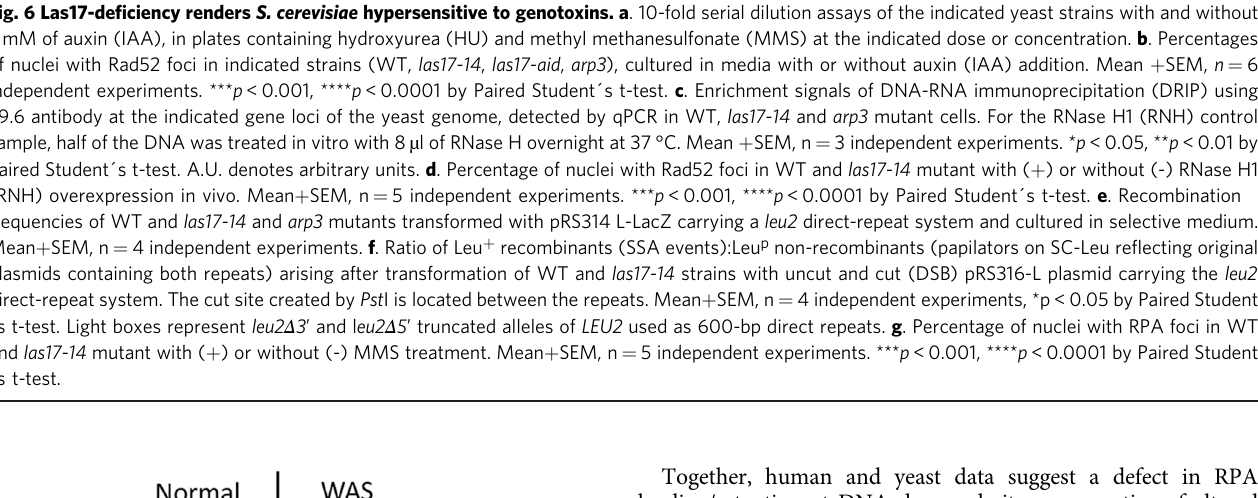
Fig. 6 Las17-de fi ciency renders S. cerevisiae hypersensitive to genotoxins. a . 10-fold serial dilution assays of the indicated yeast strains with and without 2 mM of auxin (IAA), in plates containing hydroxyurea (HU) and methyl methanesulfonate (MMS) at the indicated dose or concentration. b . Percentages of nuclei with Rad52 foci in indicated strains (WT, las17-14 , las17-aid , arp3 ), cultured in media with or without auxin (IAA) addition. Mean + SEM, n = 6 independent experiments. *** p < 0.001, **** p < 0.0001 by Paired Student´s t-test. c . Enrichment signals of DNA-RNA immunoprecipitation (DRIP) using S9.6 antibody at the indicated gene loci of the yeast genome, detected by qPCR in WT, las17-14 and arp3 mutant cells. For the RNase H1 (RNH) control sample, half of the DNA was treated in vitro with 8 µ l of RNase H overnight at 37 °C. Mean + SEM, n = 3 independent experiments. * p < 0.05, ** p < 0.01 by Paired Student´s t-test. A.U. denotes arbitrary units. d . Percentage of nuclei with Rad52 foci in WT and las17-14 mutant with ( + ) or without (-) RNase H1 (RNH) overexpression in vivo. Mean + SEM, n = 5 independent experiments. *** p < 0.001, **** p < 0.0001 by Paired Student´s t-test. e . Recombination frequencies of WT and las17-14 and arp3 mutants transformed with pRS314 L-LacZ carrying a leu2 direct-repeat system and cultured in selective medium. Mean + SEM, n = 4 independent experiments. f . Ratio of Leu + recombinants (SSA events):Leu p non-recombinants (papilators on SC-Leu re fl ecting original plasmids containing both repeats) arising after transformation of WT and las17-14 strains with uncut and cut (DSB) pRS316-L plasmid carrying the leu2 direct-repeat system. The cut site created by Pst I is located between the repeats. Mean + SEM, n = 4 independent experiments, *p < 0.05 by Paired Student ´s t-test. Light boxes represent leu2 Δ 3 ’ and l eu2 Δ 5 ’ truncated alleles of LEU2 used as 600-bp direct repeats. g . Percentage of nuclei with RPA foci in WT and las17-14 mutant with ( + ) or without (-) MMS treatment. Mean + SEM, n = 5 independent experiments. *** p < 0.001, **** p < 0.0001 by Paired Student ´s t-test.